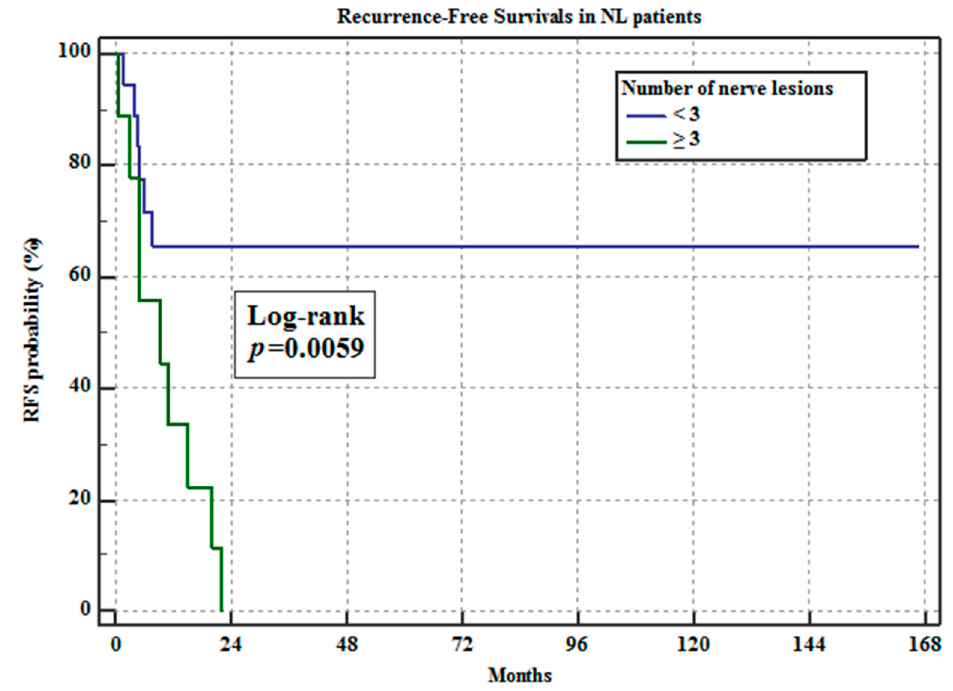
Figure 5. Kaplan–Meier analysis for RFS.